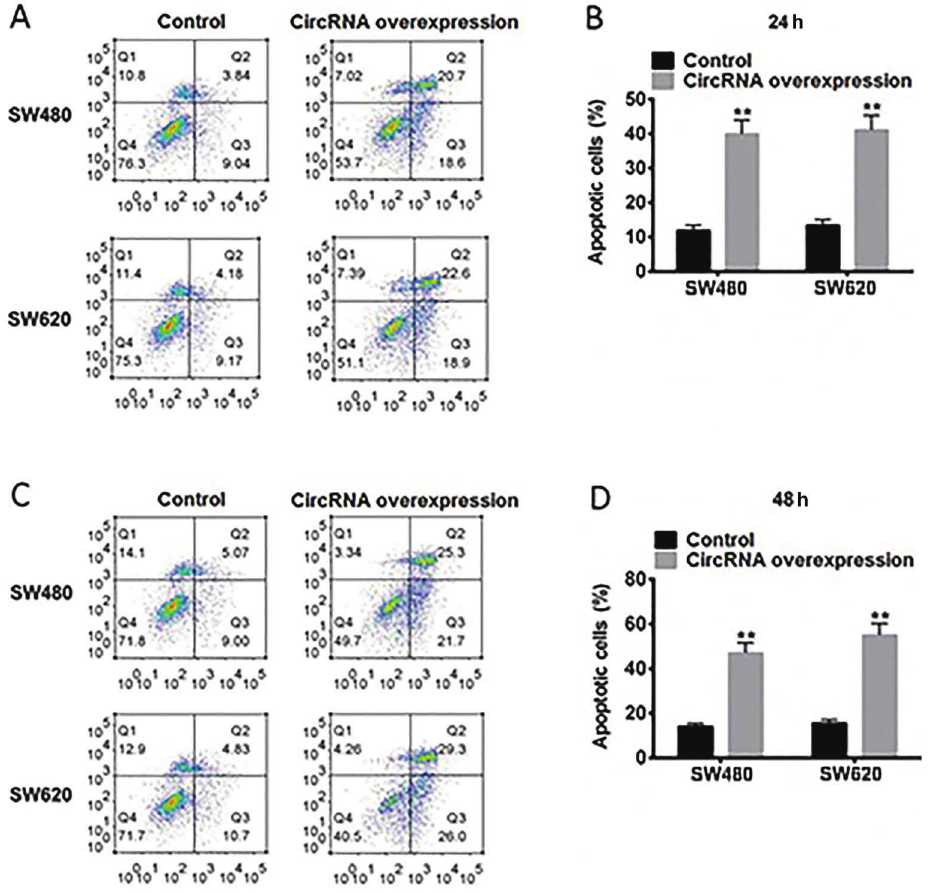
Figure 3. Hsa_circ_0000523 induced apoptosis in human colorectal cancer cells. A and C , Representative images of fl ow cytometry analysis in SW480 and SW620 cells. The early and late apoptosis was quanti fi ed and indicated in Q3 and Q2 gates, respectively. Percentage of apoptotic cells after 24 h ( B ) and 48 h ( D ). Data are reported as means ± SE from three independent experiments. **P o 0.01 ( t